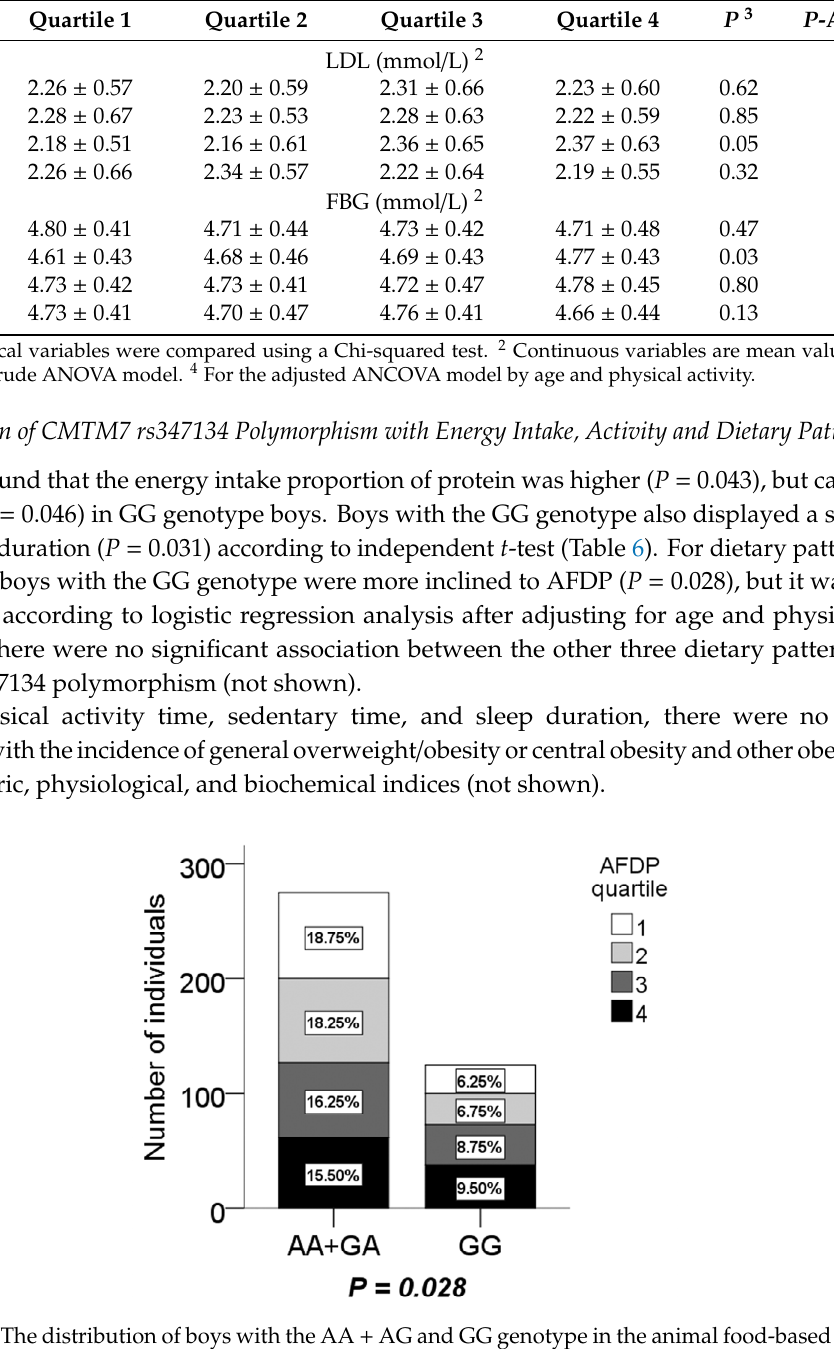
Figure 1. The distribution of boys with the AA + AG and GG genotype in the animal food-based dietary pattern (AFDP) quartile. The last quartile of the AFDP compared to the first quartile had a significantly higher percentage of individuals with the GG genotype, but lower with the AA+AG genotype.